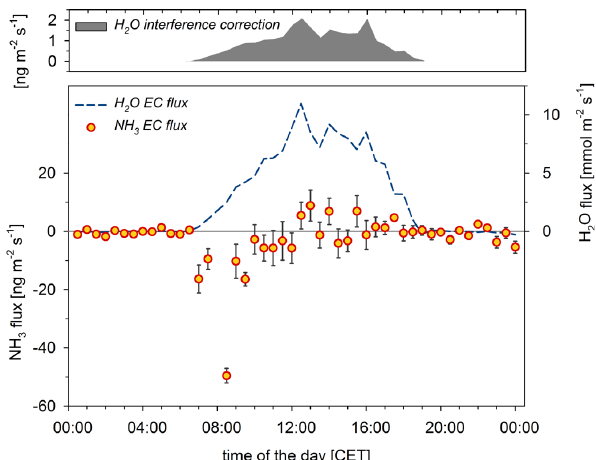
Fig. 12. Lower panel: EC fluxes of NH 3 (evaluated at constant delay time τ fix , raw NH 3 data are corrected for H 2 O interference) and of H 2 O during conditions of small NH 3 exchange fluxes 9 days after the grassland fertilisation on 15 August 2009; upper panel: amount of NH 3 flux due to H 2 O